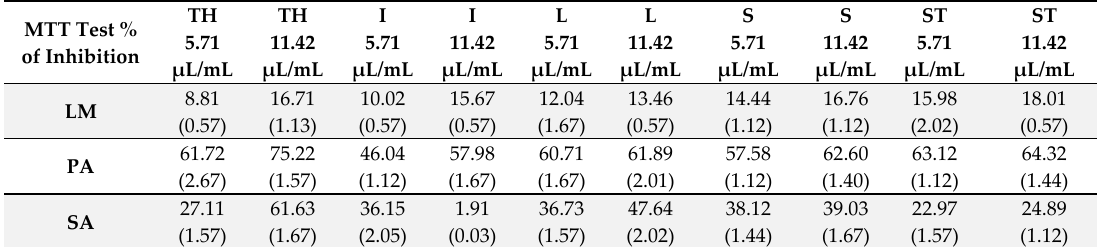
Table 2. Metabolic activity exhibited by the cells present within the bacterial biofilms in the presence of different volumes of the monofloral honeys. Results are reported as percentage of inhibition with respect to the control (which % of inhibition was assumed = 0). They are the mean (±SD) of